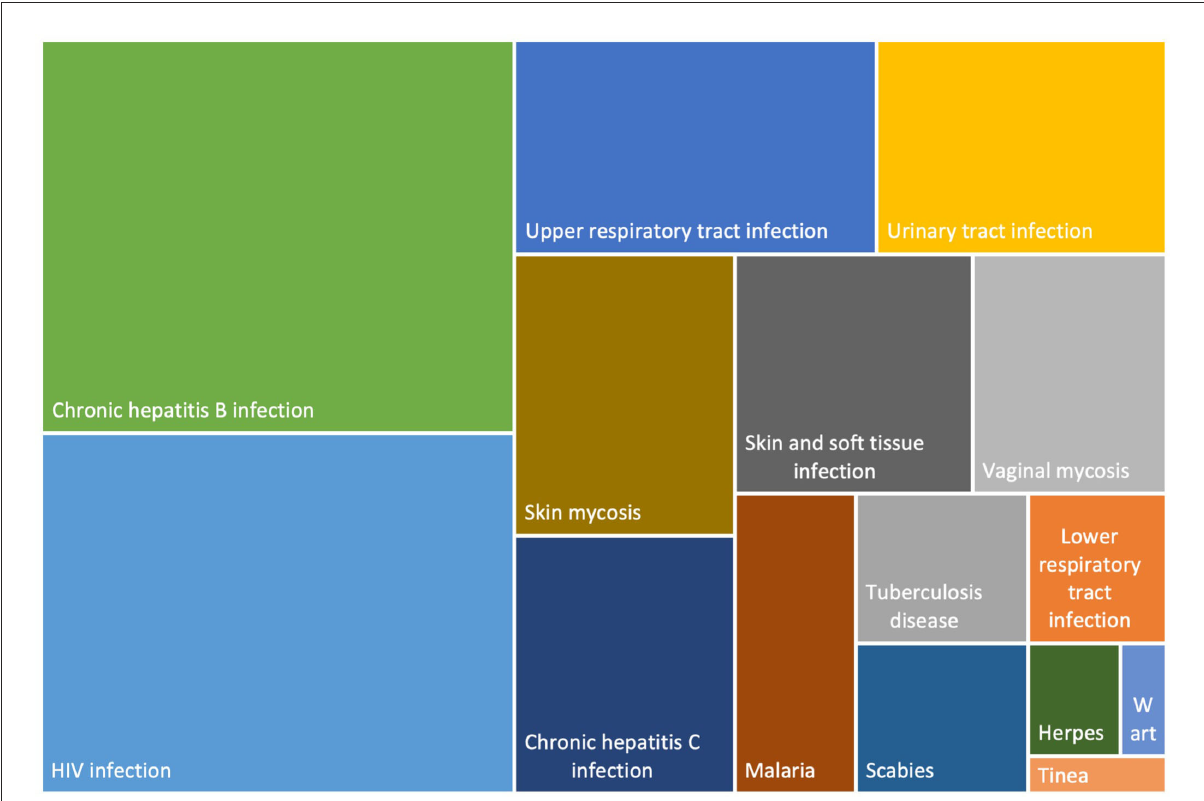
FIGURE2 Distribution of infectious diseases among undocumented migrants in Paris and Bordeaux, Premier Pas survey ( n =